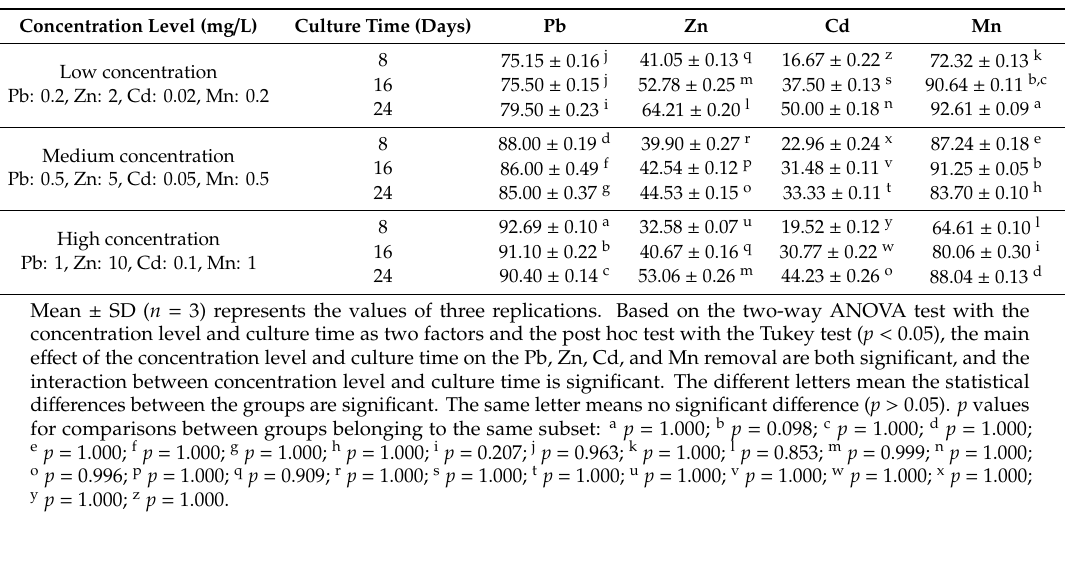
Table 4. Removal of Pb, Zn, Cd, and Mn from karst water by Eichhornia crassipes at di ff erent initial concentrations in the multi-component heavy metal system